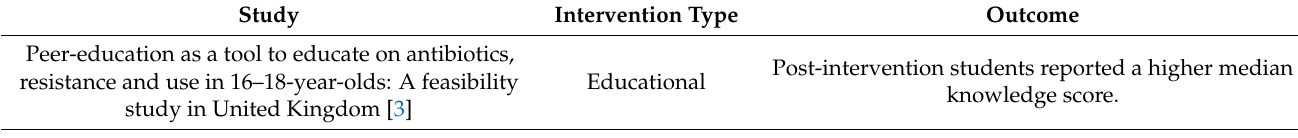
Table 1. Types of interventions and